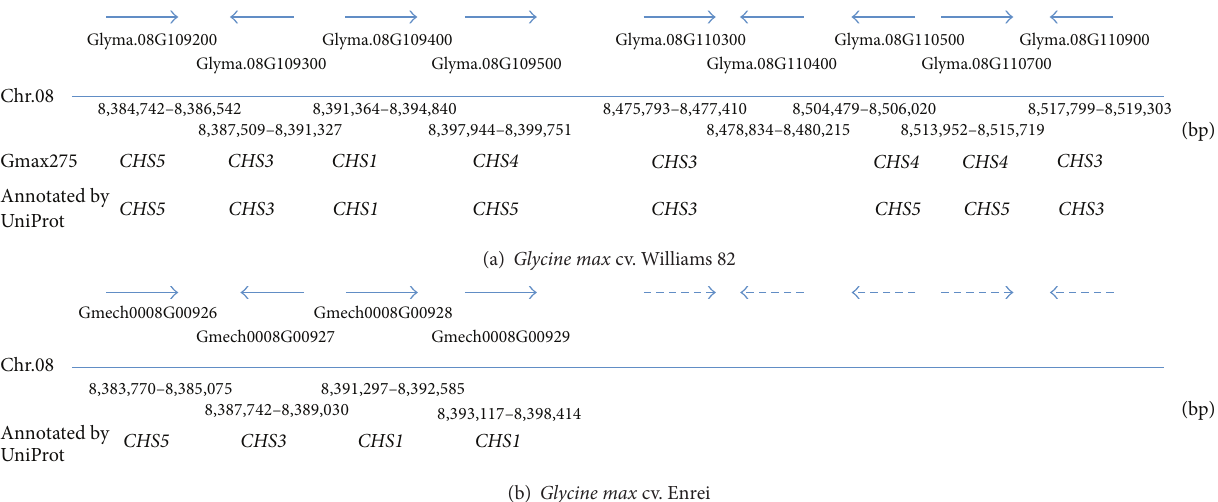
Figure 3: A region in soybean chromosome 8 showing the position of CHS gene clusters. The region encompassing 8.3 ∼ 8.5 Mb of soybean chromosome 8 of Williams 82 Gmax275 (a) and Enrei cultivar (b) is characterized by CHS gene clusters. Most of the CHS genes correspond in both cultivars as indicated by the position and UniProt annotation of identified genes. However many CHS genes could not be localized in Enrei cultivar due to fragmented sequence.